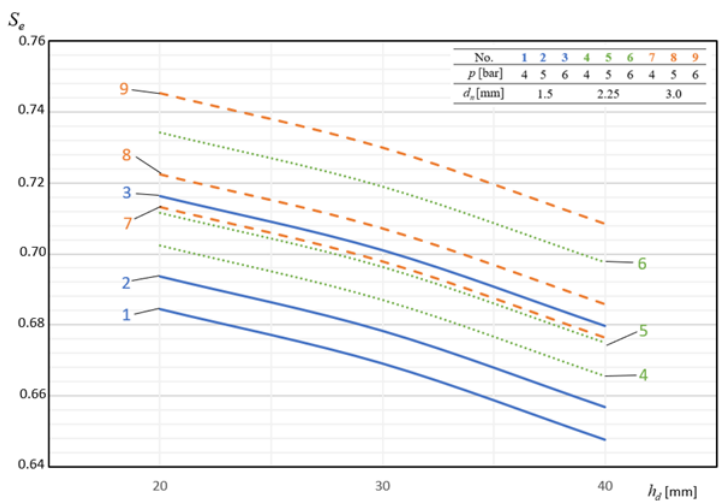
Figure 12. Influence of the distance of the blowing nozzles from the material on the shaping of the machine’s operating efficiency at constant parameters 𝑛 𝑑 = 2 and 𝑣 𝑝 = 60 pcs./min.